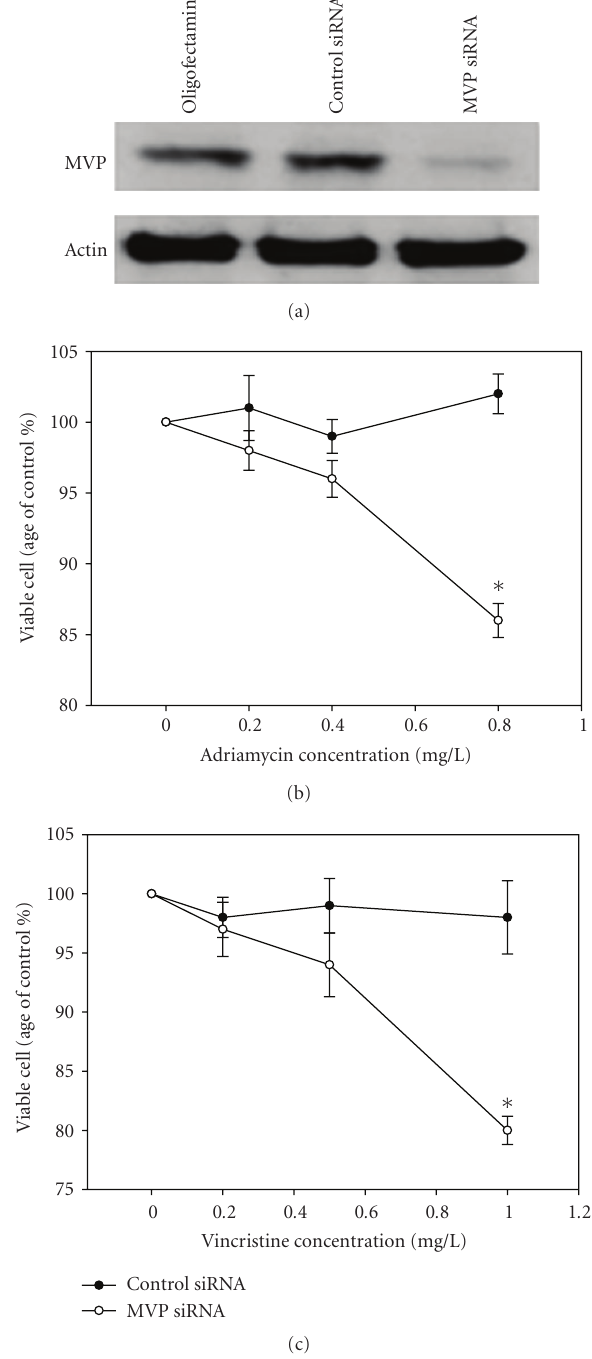
Figure 5: The e ff ect of MVP siRNA treatment on chemosensitivity in SGC7901/VCR cells. (a) Western blot analysis showed that treatment of SGC7901/VCR cells with MVP siRNA significantly reduced MVP protein levels, whereas MVP protein expressions was not significantly suppressed by control siRNA. (b) MTT assay showed that MVP siRNA transfection could significantly decrease the cell viability of SGC7901/VCR cells incubated with adriamycin and vincristine. The experiment was repeated in triplicate. Points, mean viable cells (% of control) from three experiments; bars, SE. ∗ , P ≤ . 05 di ff er from control by t -test. Oligofectamine, cells treated with oligofectmine